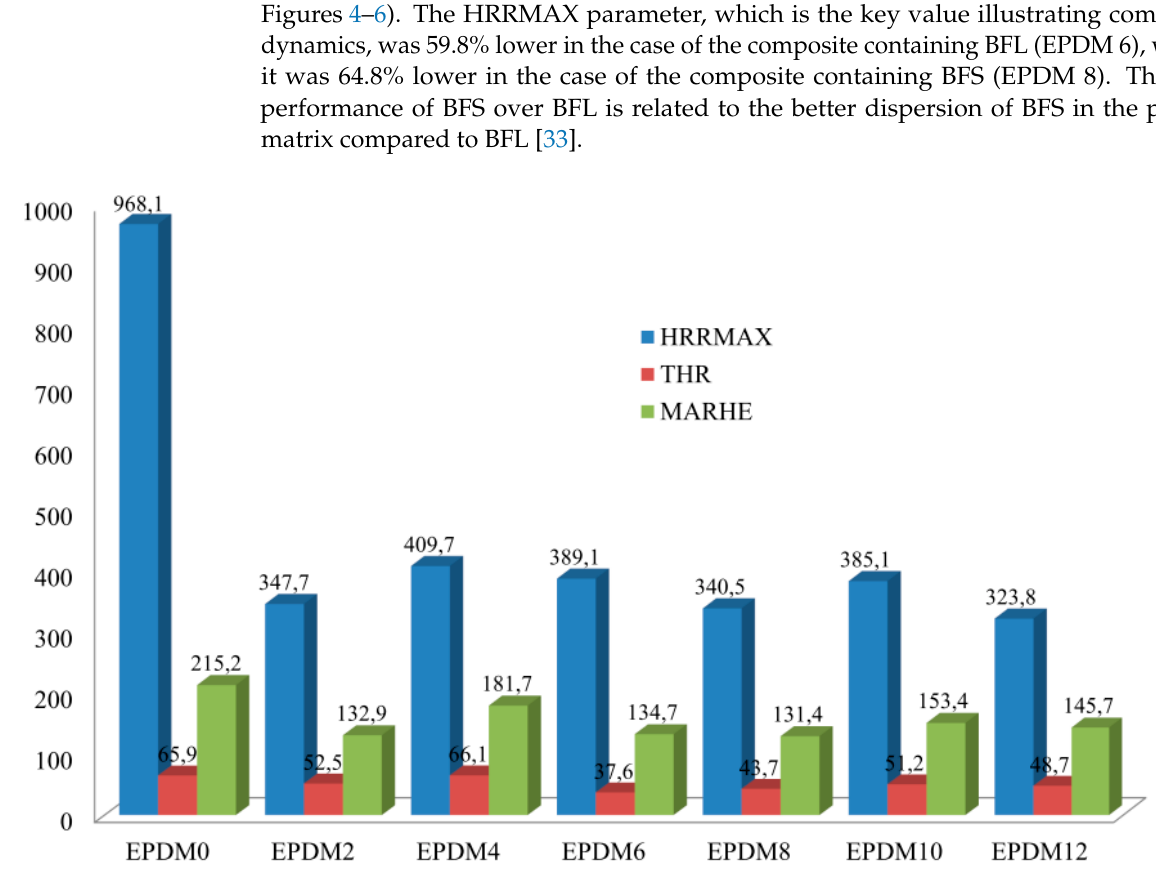
Figure 4. Flammability parameters of the EPDM-filler composites.